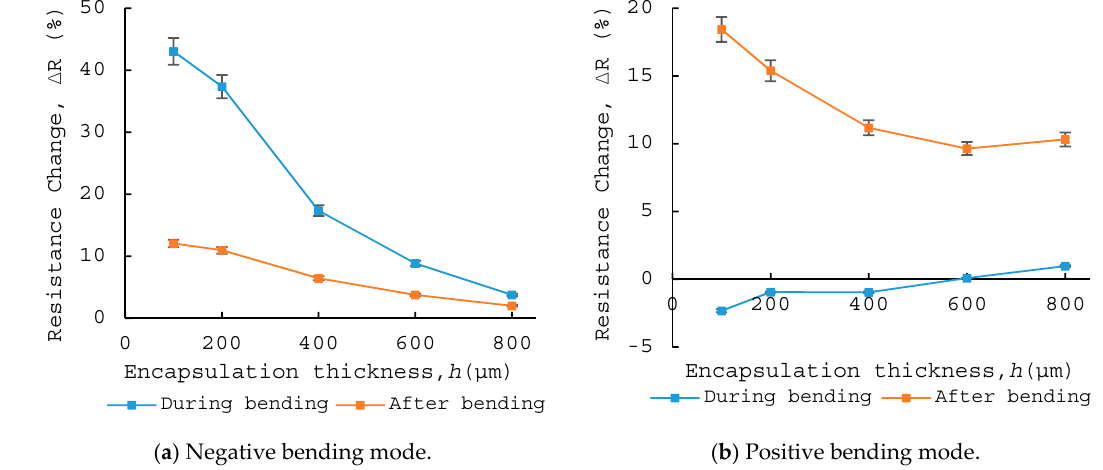
Figure 4. Resistance changes for gauges on Escalade fabric along warp weave (or stiff)